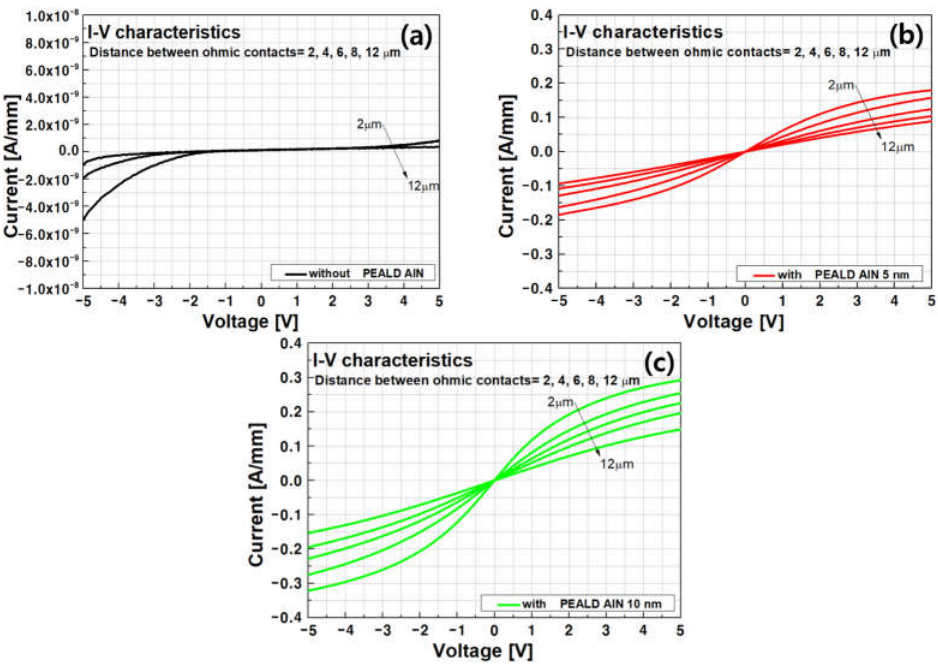
Figure 7. Current-voltage characteristics measured between two ohmic contacts with different distances; ( a ) reference sample without PEALD AlN film, ( b ) sample with a 5 nm thick PEALD AlN film, and ( c ) sample with a 10 nm thick PEALD AlN film.